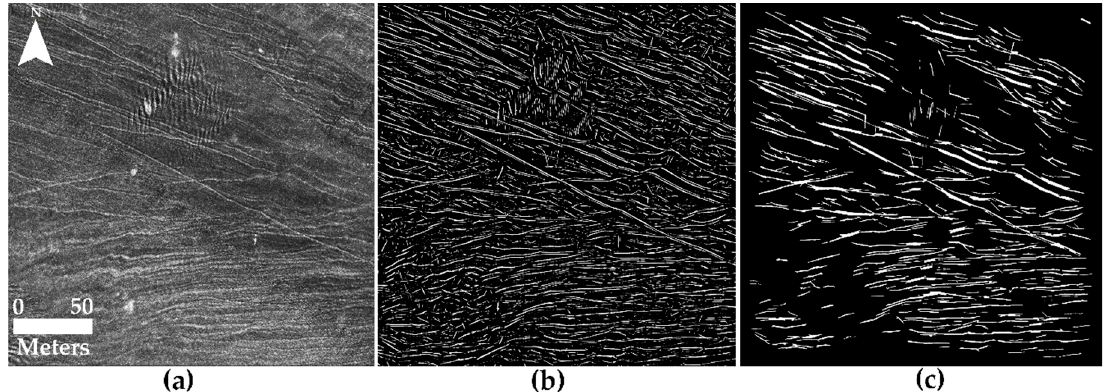
Figure 9. ( a ) The original SSS image, ( b ) the automatically detected linear features, ( c ) the final extracted TMs which meet the inclusive criteria.